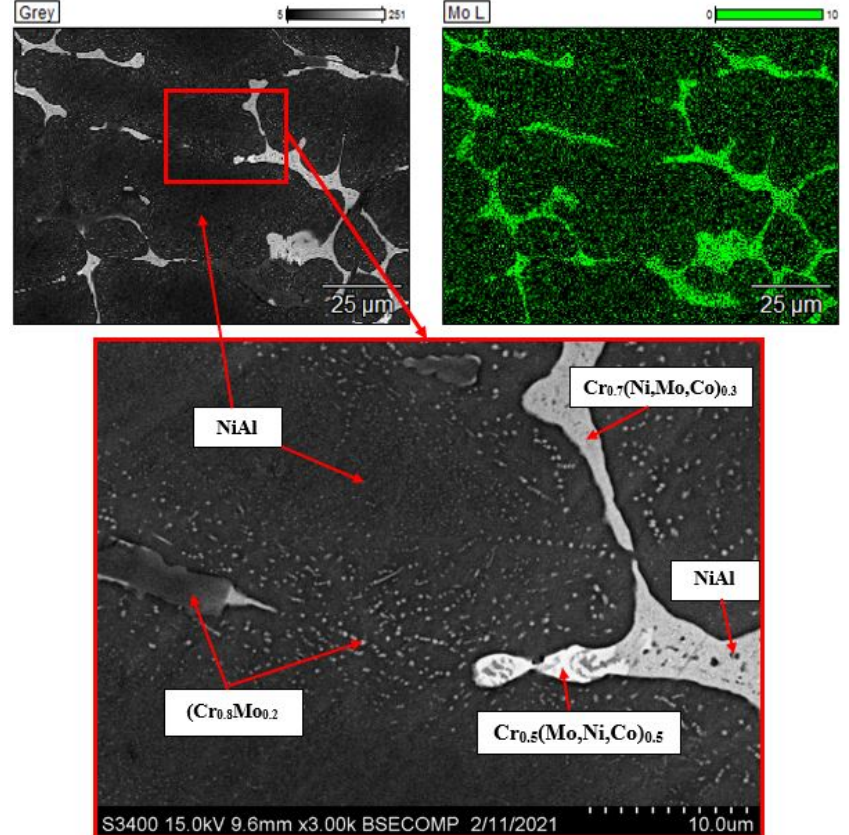
Figure 5. The microstructure of the alloy doped with 2.5% of molybdenum and the map of dopant distribution. Since microcracks propagate in intermetallic materials predominantly at intergrain boundaries via a longer path (to go round inclusions) [15,16], it is fair to assume that the alloy containing molybdenum precipitates will be characterized by increased ductility at room temperature. The intergrain space of the Zr-doped alloy (Figure 6) was found to contain zone seg- regations of Ni5Zr. The characteristic size of the structural components and the principle of microstructure formation are similar to those for the developed Hf-doped CompoNiAl- M5-3 alloy [23–26]. It can be assumed that this microheterogeneous structure will not cause deterioration of mechanical properties.